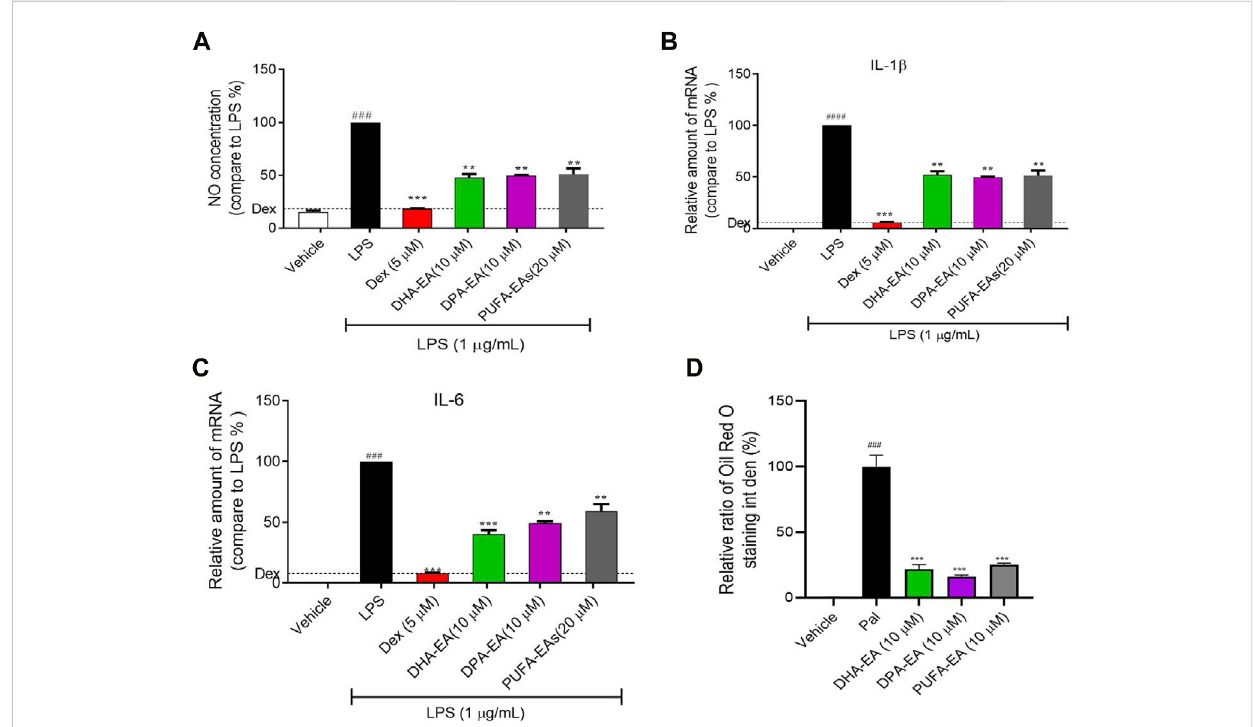
FIGURE 9 The PUFA-EA mixture showed excellent anti-in fl ammation activities in LPS-stimulated RAW264.7 cells. (A) The NO levels in the medium. (B,C) The mRNAlevelsofIL-1 β andIL-6. (D) Quanti fi cationanalysisofOilRedOstaininginSupplementaryFigureS7.Intdenstandsforintegrateddensity.Alldatain the fi gureareshownasmean±SD(n ≥ 3).Barsrepresentthestandarddeviationfromtriplicatedeterminations.Student ’ st-testwasusedforthestatistical analysis,# p < 0.05,## p < 0.01,and### p < 0.001,comparedwiththecontrolgroup;* p < 0.05and** p < 0.01,*** p < 0.001,comparedwiththeLPS alone-stimulated group.